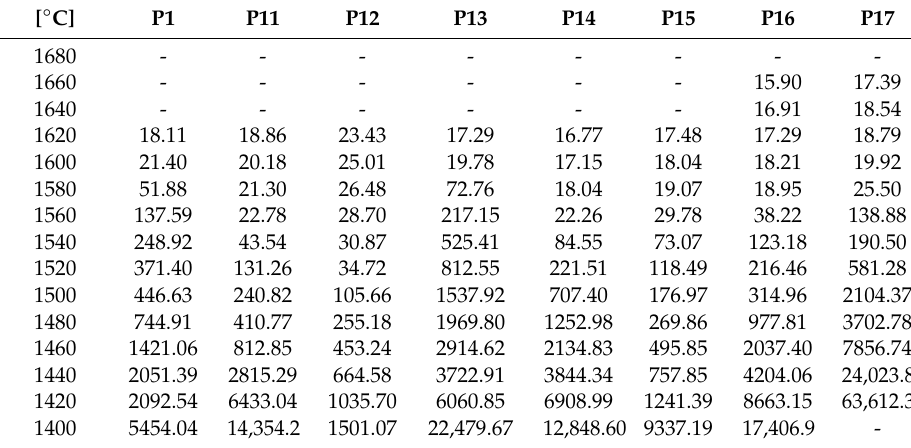
Figure 6. Viscosity of the BOF slag with 2 ( a ) and 8 mass% of MgO ( b ) as function of MnO content. The measured viscosity values are presented in the Tables 5 and 6. Table 5. Viscosity of the BOF slags with 2 mass% MgO [mPa*s].